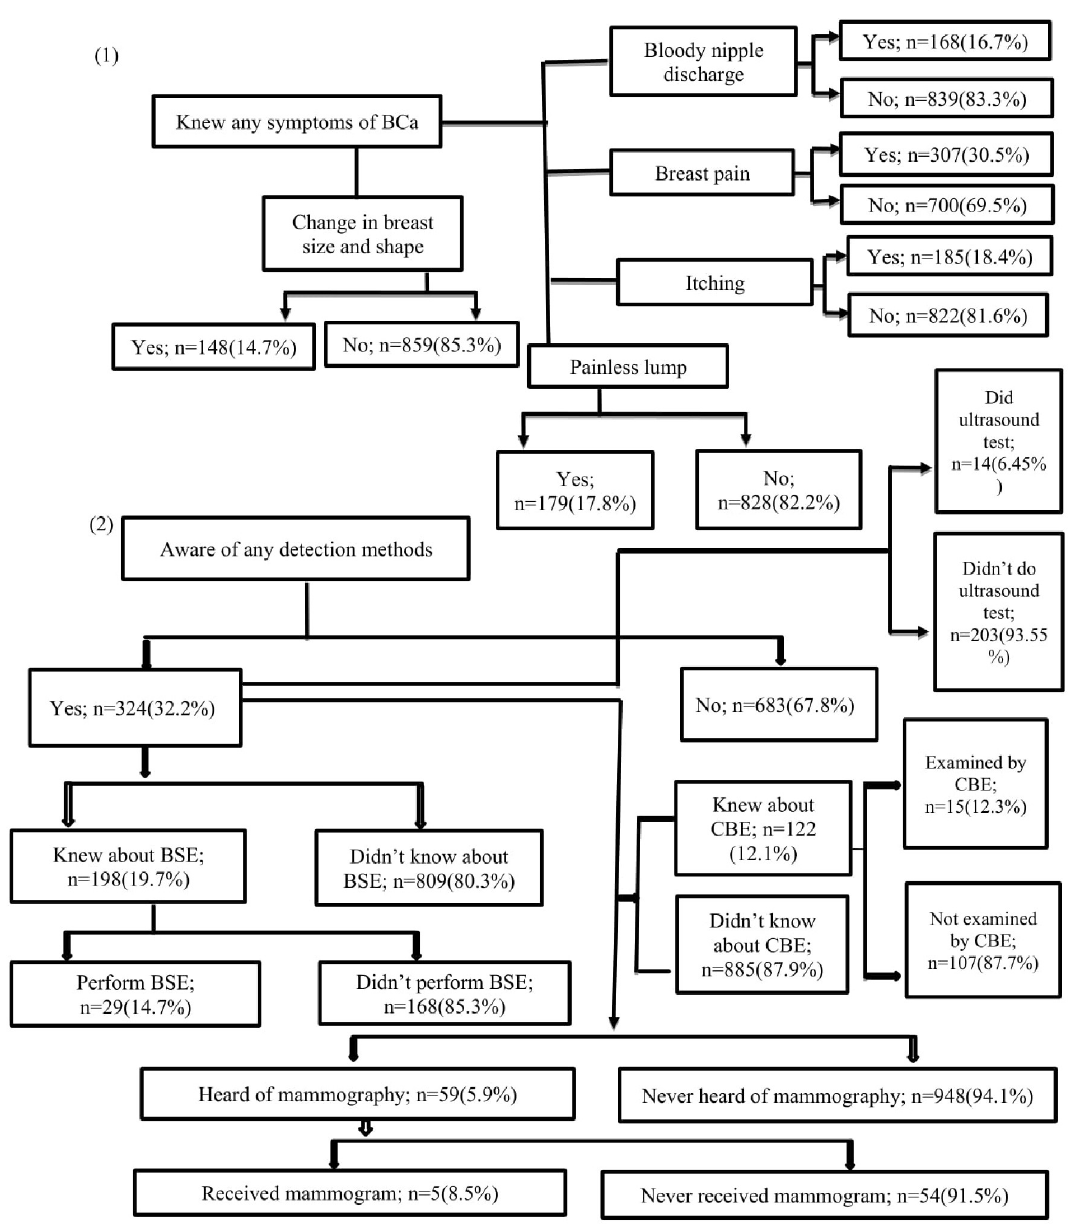
Fig 1. Knowledge and practices of breast cancer and early detection